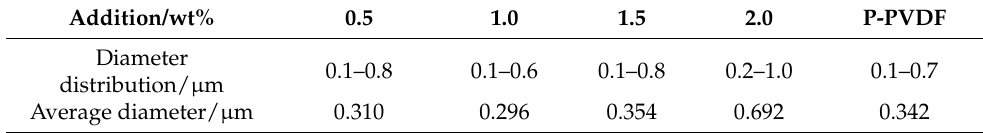
Figure 19. The fiber diameter distribution at different addition of nanographene: ( a ) the addition of 0.5 wt%; ( b ) the addition of 1.0 wt%; ( c ) the addition of 1.5 wt%; ( d ) the addition of 2.0 wt%. Table 9. The average diameter of the fiber membrane at different loading of nanographene. Addition/wt%